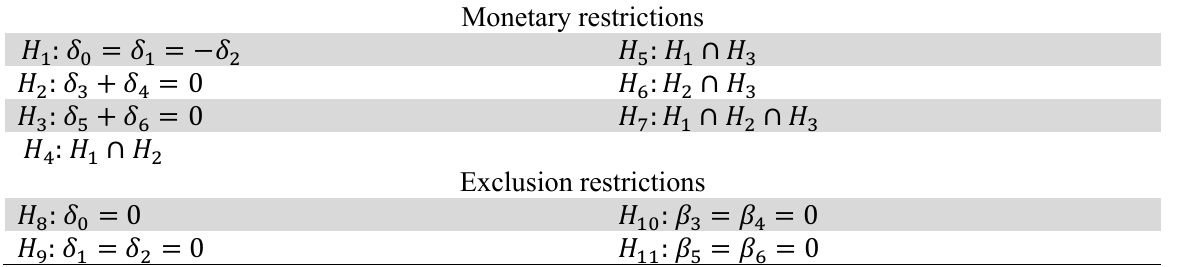
Tests of exclusion restriction and monetary